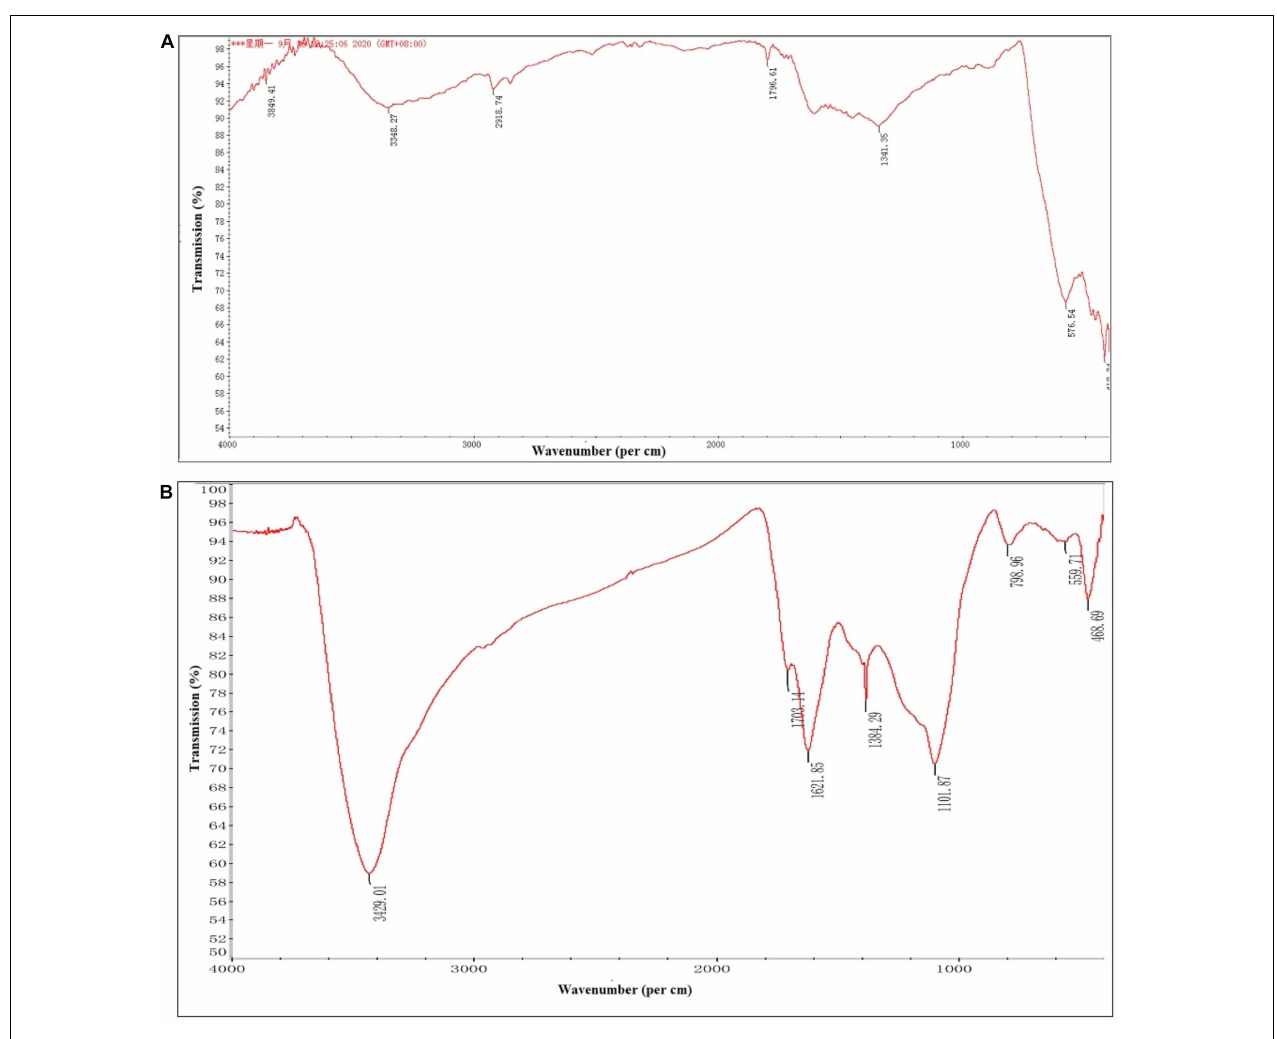
FIGURE 5 | Fourier-transform infrared spectroscopy pattern of biochar particles and Cordyceps fumosorosea -biochar nanoparticles. (A) Biochar particles. (B) Cordyceps fumosorosea -biochar